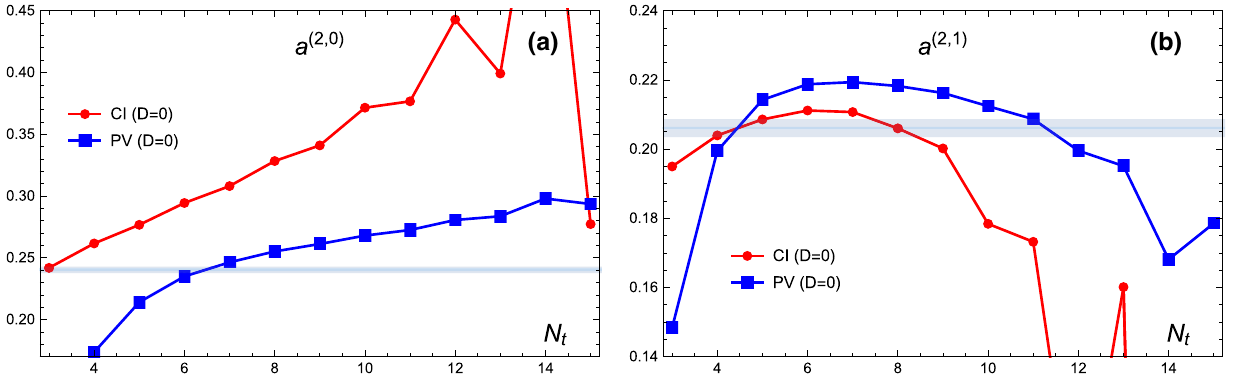
Fig. 10 a The moment a ( 2 , 0 ) (σ m ) ( D = 0 ) as a function of the trunca- tion index N t , in the CIPT (’CI’) and PV approaches. b The same, but for the moment a ( 2 , 1 ) (σ m ) ( D = 0 ) . The QCD coupling is kept fixed this